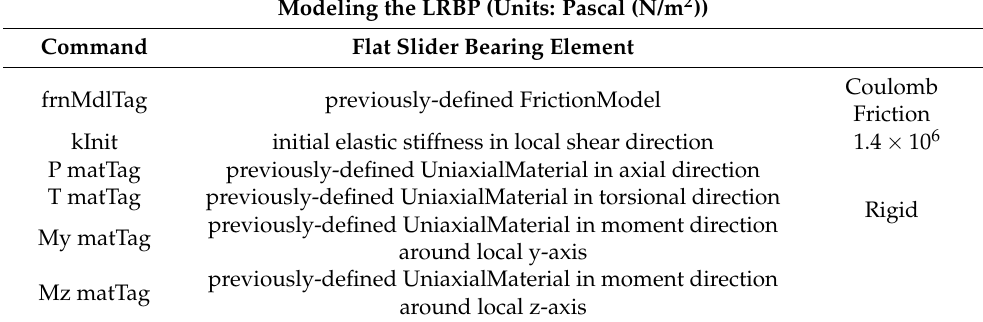
Figure 10. Flat slider bearing element. Table 5. Details of the modeling of the LRBP.